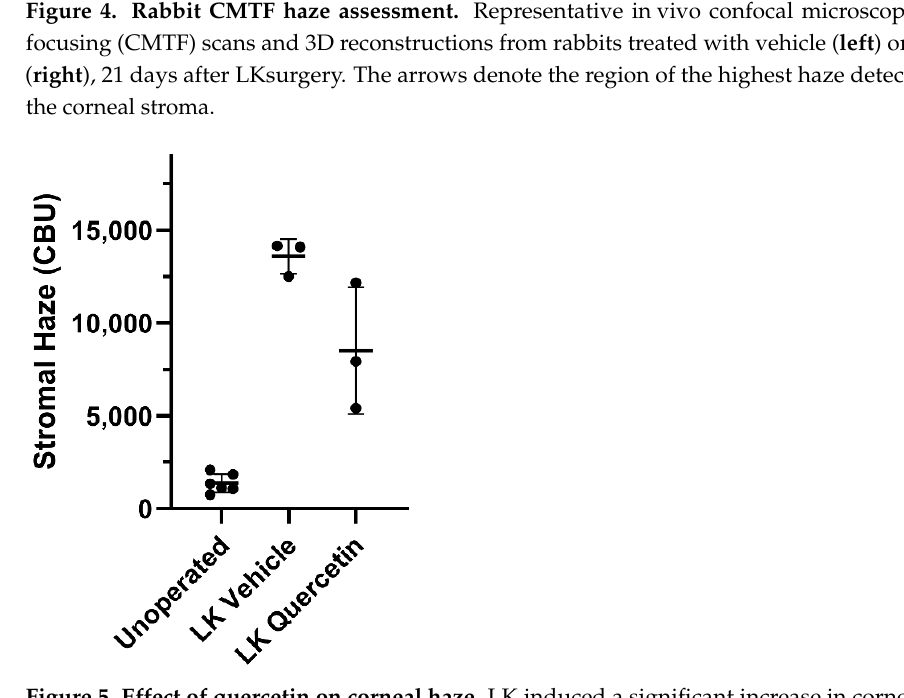
Figure 5. Effect of quercetin on corneal haze. LK induced a significant increase in corneal stromal backscatter (haze) in corneas treated with vehicle alone. In two of the three rabbits, a decrease in corneal haze was detected in the quercetin-treated group as compared to control rabbits (vehicle- treated), but this difference was not statistically significant (Brown-Forsythe ANOVA test and Dun- nett’s T3 multiple comparison test). CBU = confocal backscatter units.